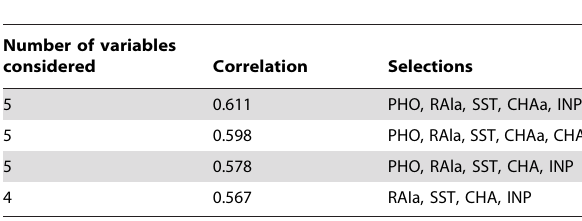
Table 5. Bio-ENV results showing the environmental variable combinations that best match the biotic similarity matrices using the weighted Spearman rank correlation ( r w